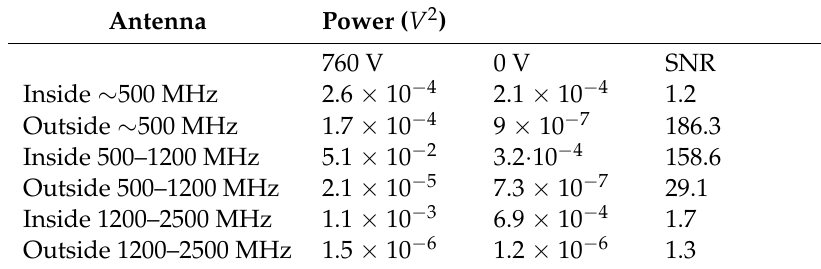
Table 8. Accumulated power and SNR for surface PD in twisted pair inside the tank when measured with the inner and outer monopoles of 10 cm.